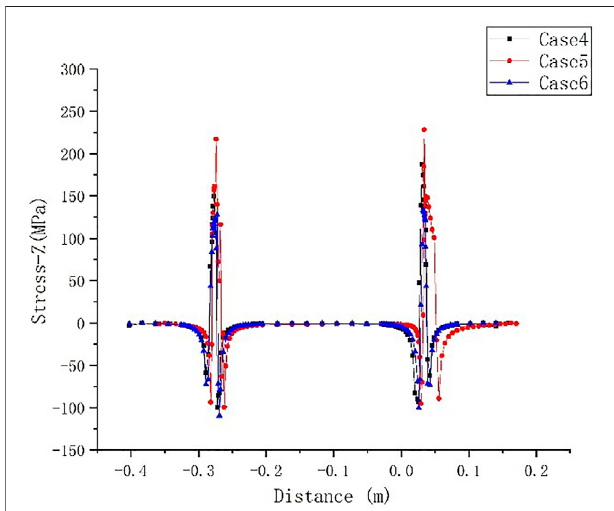
FIGURE 11 | Residual stress σ z along the z -direction (t1 = 8 mm).